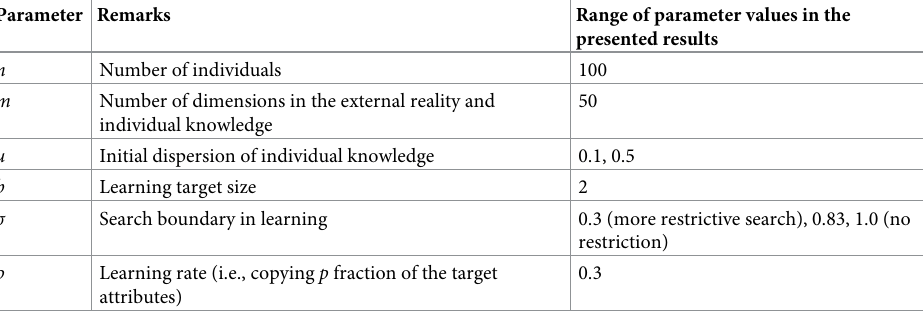
Table 1. Parameter values for presented